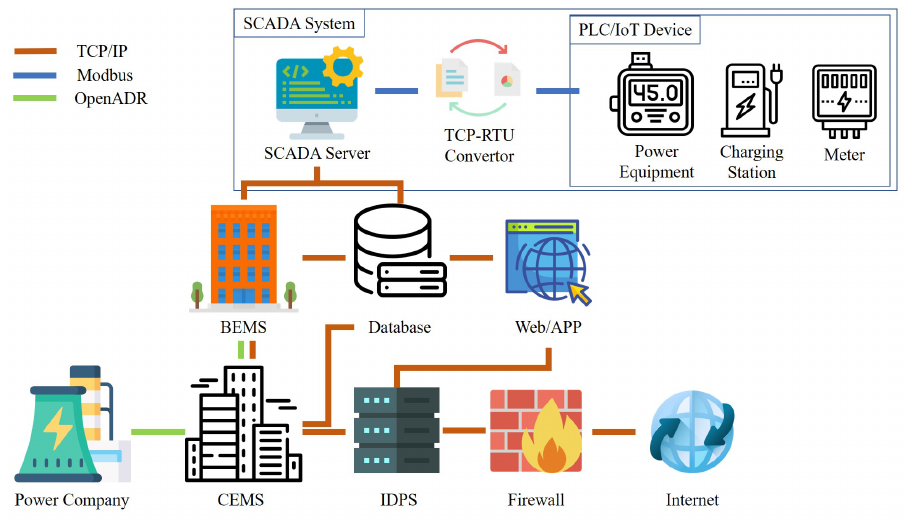
Figure 1. Energy management system in southern Taiwan.